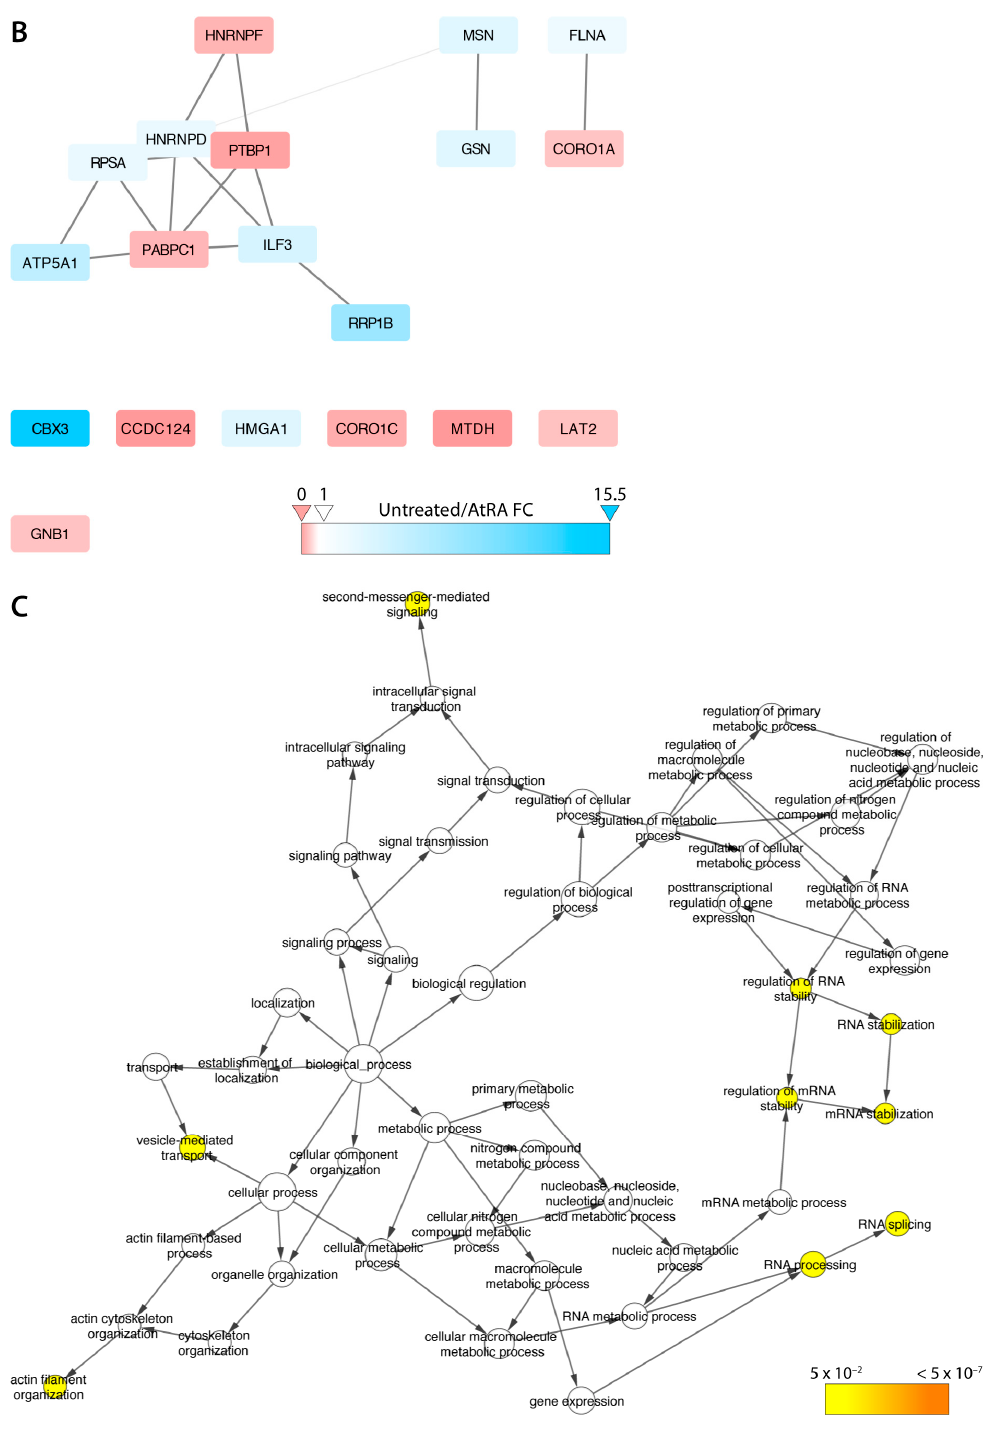
Figure 3. Gene ontology analysis of EZH2 interactome. ( A ) Gene ontology (Cytoscape–BinGO) showing significant enrichment for proteins involved in translation, RNA splicing, and gene expression. Node colour corresponds to p -value (see scale). Gene ontology analysis of EZH2 interactome (cont.); ( B ) Quantitative network analysis of EZH2-interacting proteins changing their relative frequency of interaction upon differentiation. Blue-coloured proteins represent ones found to co-IP with EZH2 at higher frequency in untreated HL-60 cells, whereas pink-coloured “preys” were found enriched in cells treated with AtRA; ( C ) Gene ontology (GO) analysis of proteins that change their interaction frequency with EZH2 upon AtRA-driven myeloid differentiation suggesting involvement in RNA metabolism, splicing, and control of gene expression.